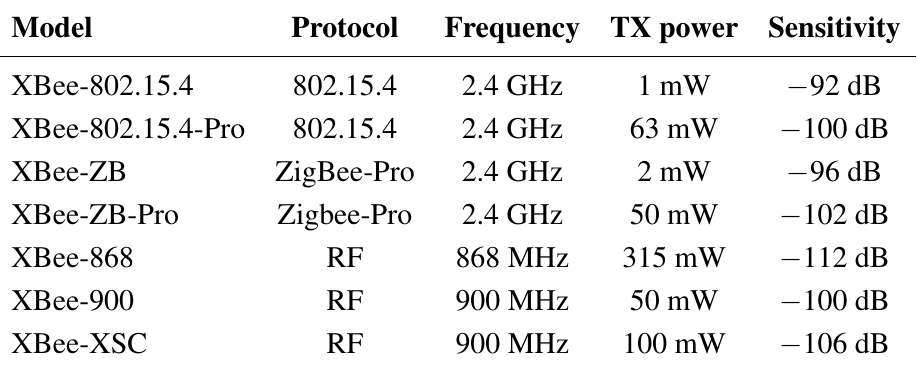
Table 1. Waspmote